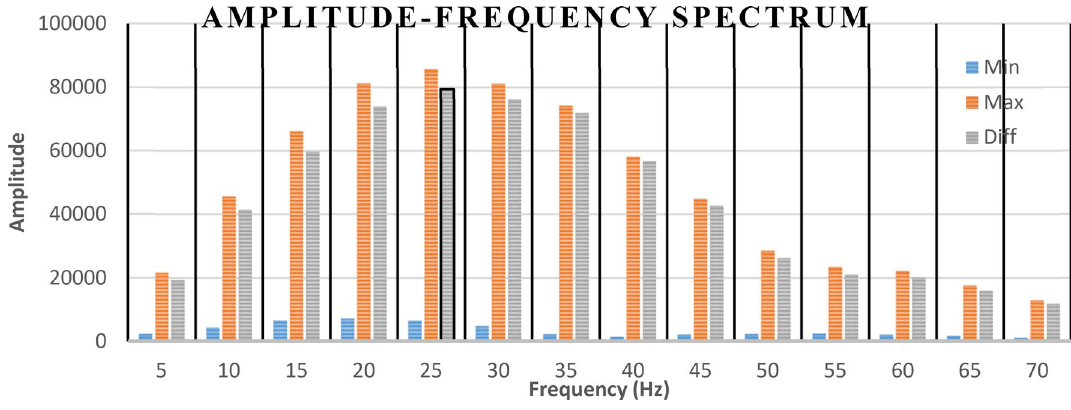
Fig. 10 Amplitude-frequency distribution analysis